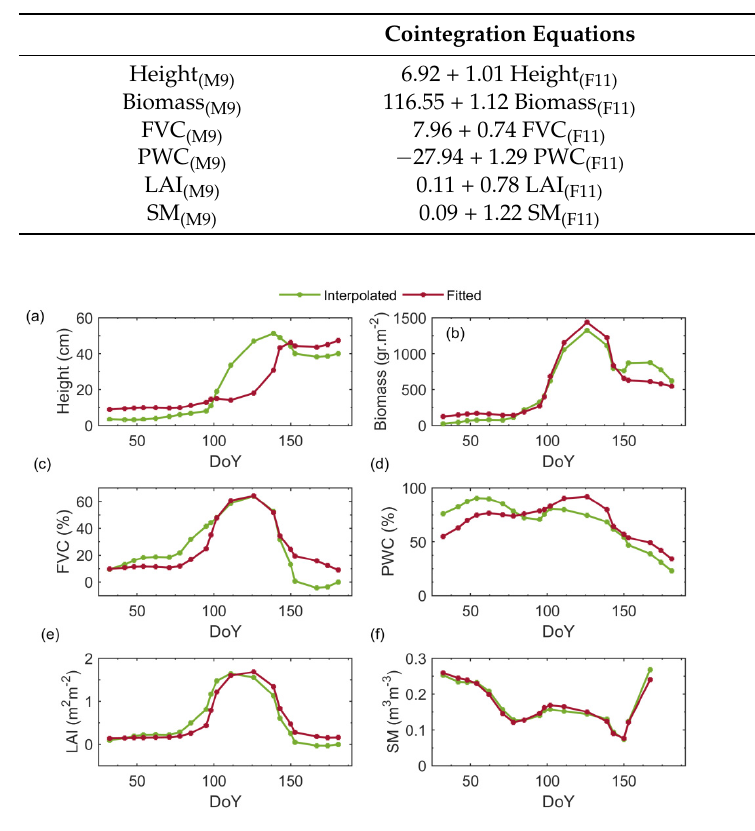
Figure 10. Interpolated real data versus cointegration—adjusted for biophysical variables of M9 plot. ( a ) Height, ( b ), Biomass, ( c ) FVC, ( d ) PWC, ( e ) LAI, ( f ) SM.